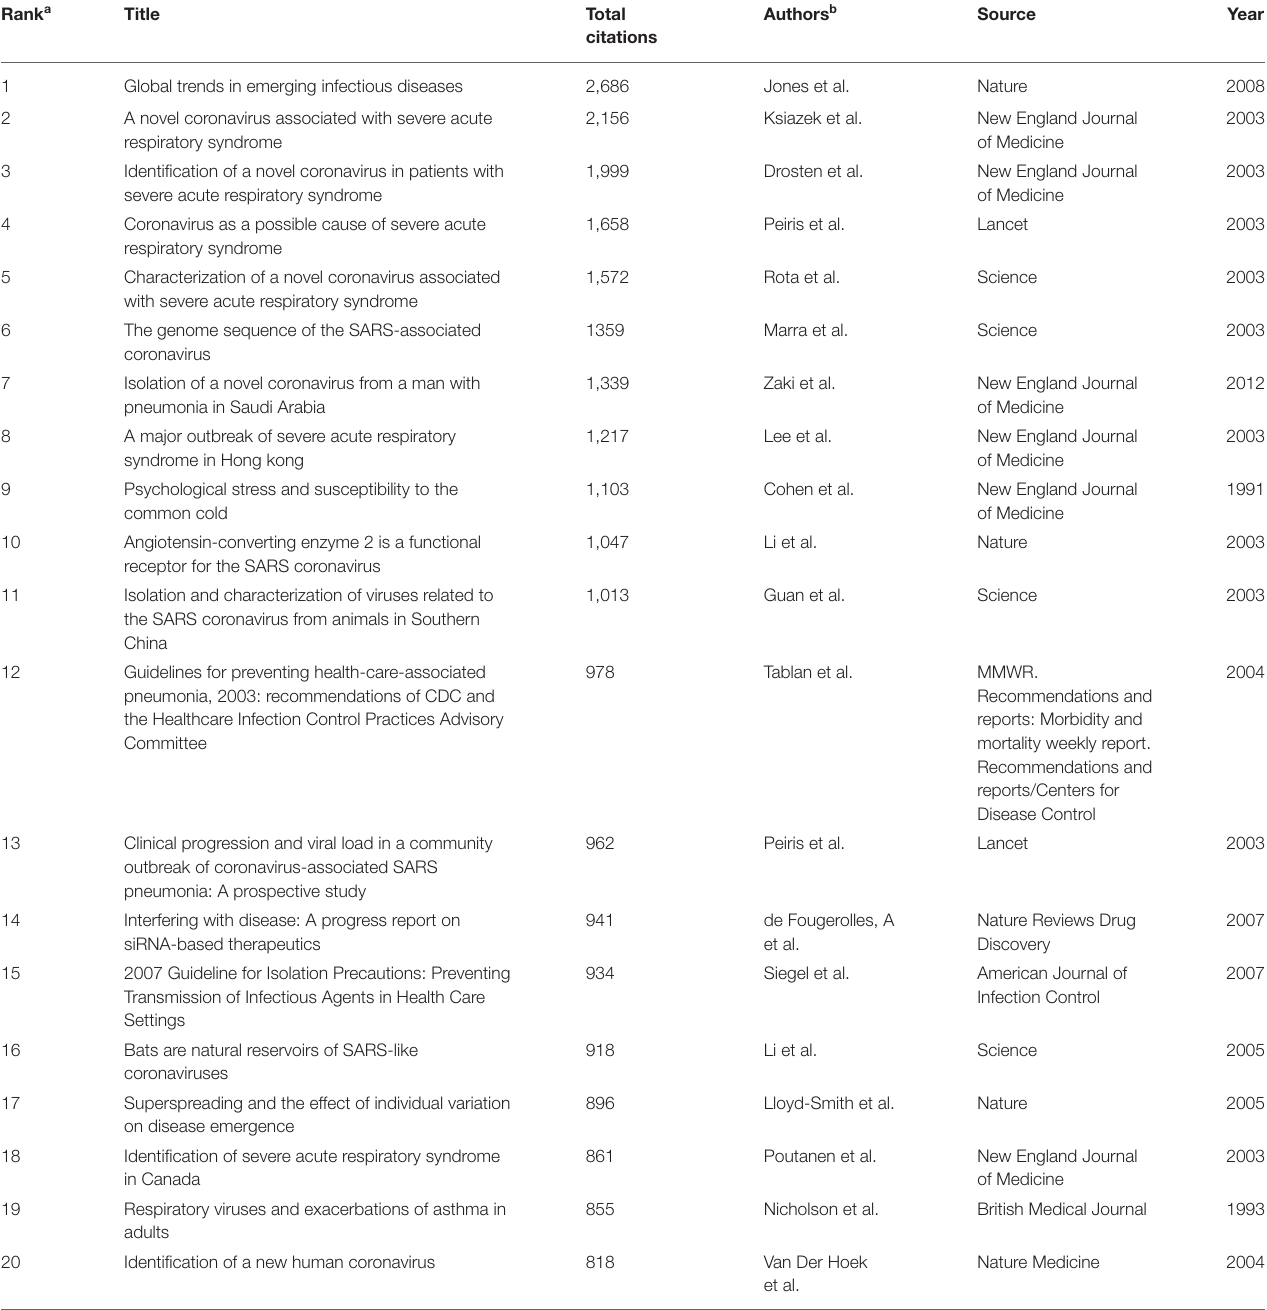
TABLE 2 | Top 20 articles with the most